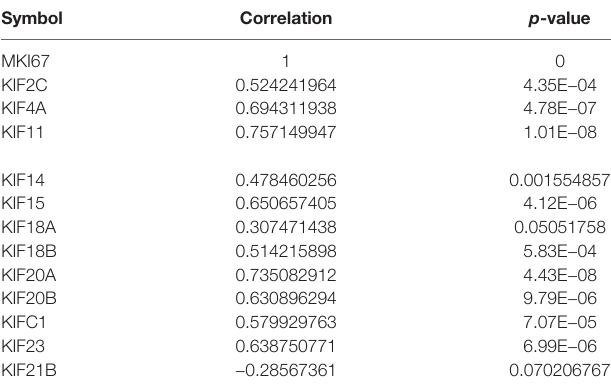
TABLE 2 | The correlation prognosis-related KIFs expression and tumor growth in 41 pancreatic cancer cell lines. Symbol Correlation p